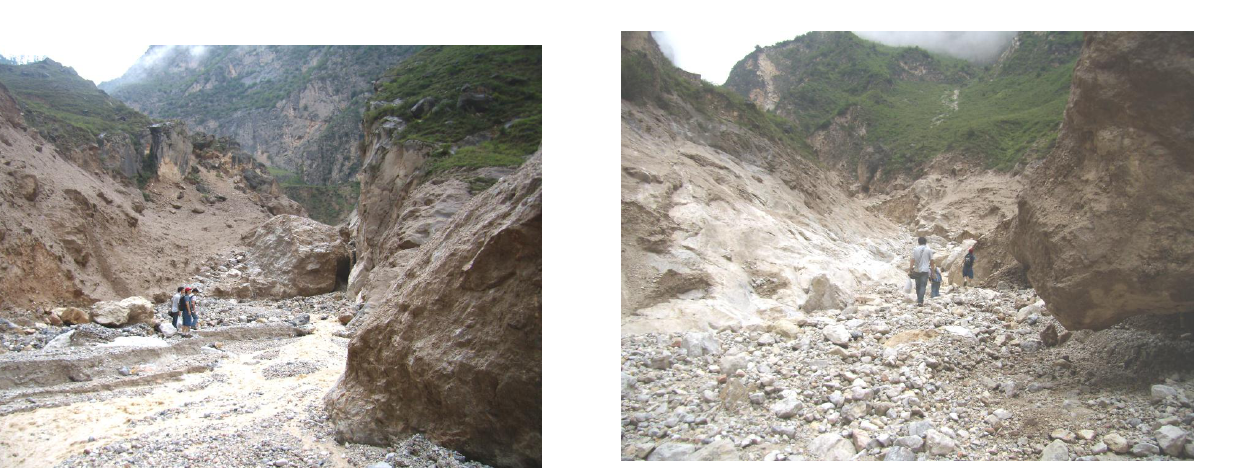
Fig. 8. Natural rockfill dam in the Sanyangyu torrent, which was scoured by the 7 August 2010 debris flow event. Only a large boulder was left in the channel after breaching of the dam.